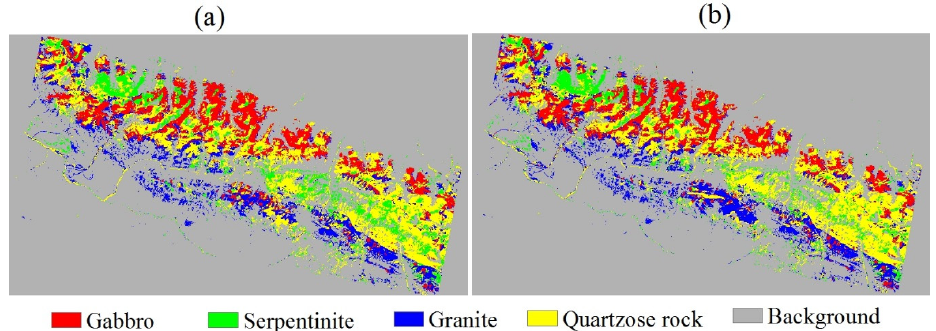
Figure 7. Landsat 8 classification results of the study area using ( a ) support vector machine (SVM) with only seven spectral vectors and no textural vector (the overall accuracy is 74.69% and κ is 0.64); and ( b ) SVM with seven textural vectors fused with seven spectral vectors (overall accuracy is 83.73% and κ is 0.77).